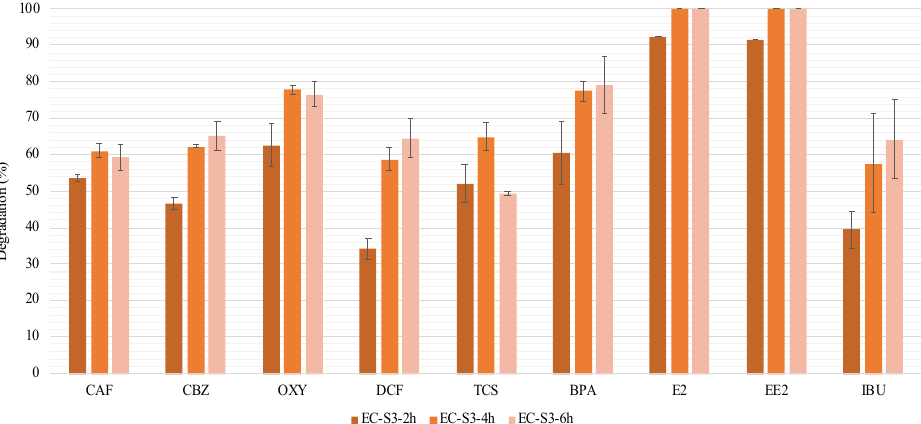
Figure 5. CECs degradation in EC-S3 experiments conducted for 2, 4 and 6 h. Standard deviation range represented by the black line.